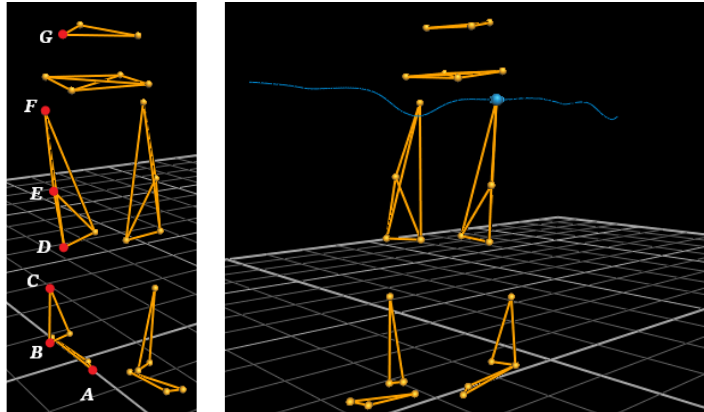
Figure 2. Visualization of the skeleton in the program Vicon Nexus